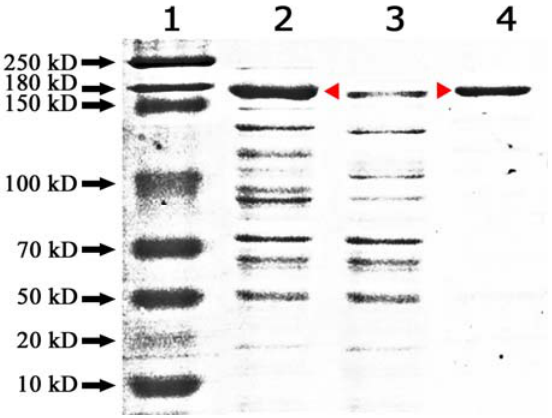
Figure 2. SDS-PAGE gel of expression and purification of BGL1. Lane 1: Protein marker, 2: Over-expression of BGL1; 3: Empty control; 4: Purified protein.